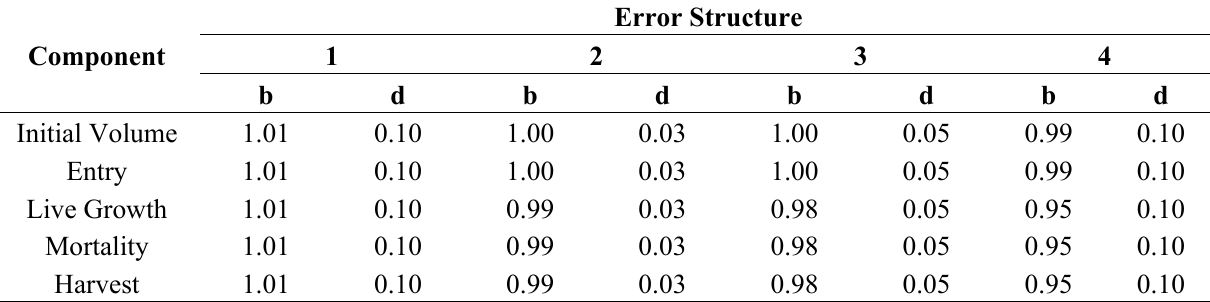
Table 2. Mean (b) and standard deviation (d) of the normal random variates used to simulate each sample